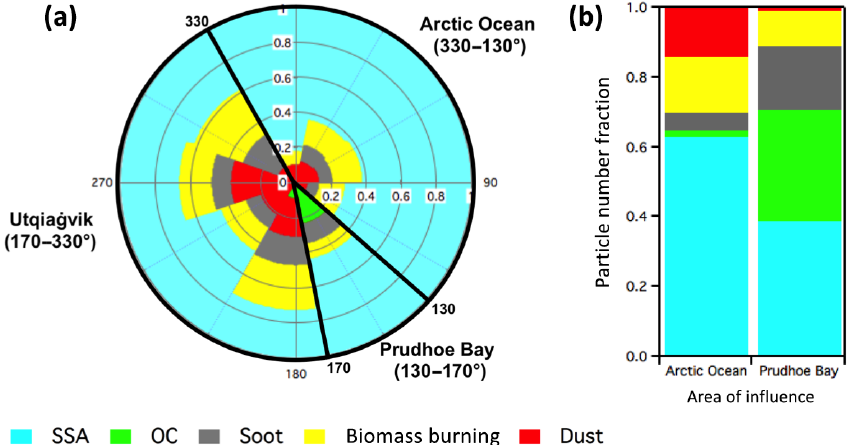
Figure 5. ATOFMS individual particle composition (0.2–1.5µm) number fractions for 496 analyzed particles from 8 to 20 September 2015, based on wind direction (a) and air mass influence (b) , determined by backward air mass trajectories. Data were binned every 40 ◦ . Table 1. Submicron and supermicron CCSEM-EDX number fractions and mole ratios for sulfate, nitrate, and chloride within individual SSA particles (SSA and partially aged SSA classes combined) during Arctic Ocean and Prudhoe Bay air masses. S, N, and Cl were confirmed as sulfate, nitrate, and chloride by ATOFMS. SSA projected Sulfate Nitrate Chloride S / Na N / Na area